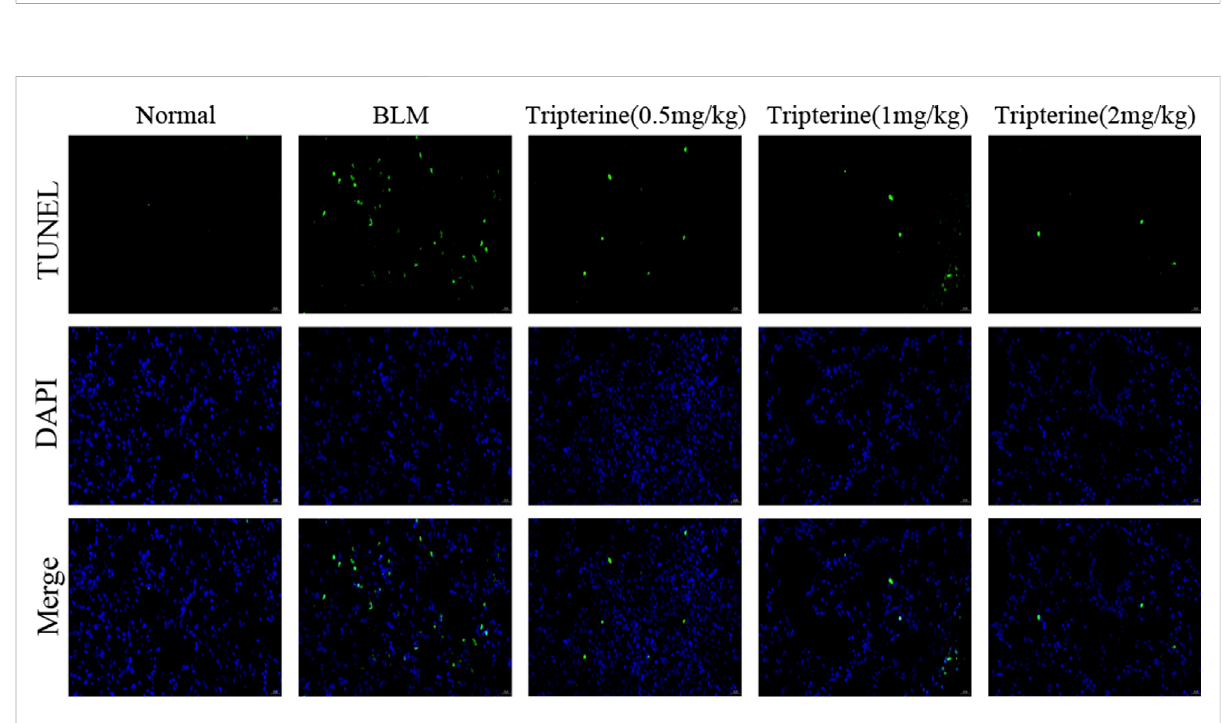
FIGURE 9 The apoptosis level of the lung tissues was analysed by immuno fl uorescence. Normal: normal group; BLM, bleomycin (5 mg/kg); scale bars: 100 μ